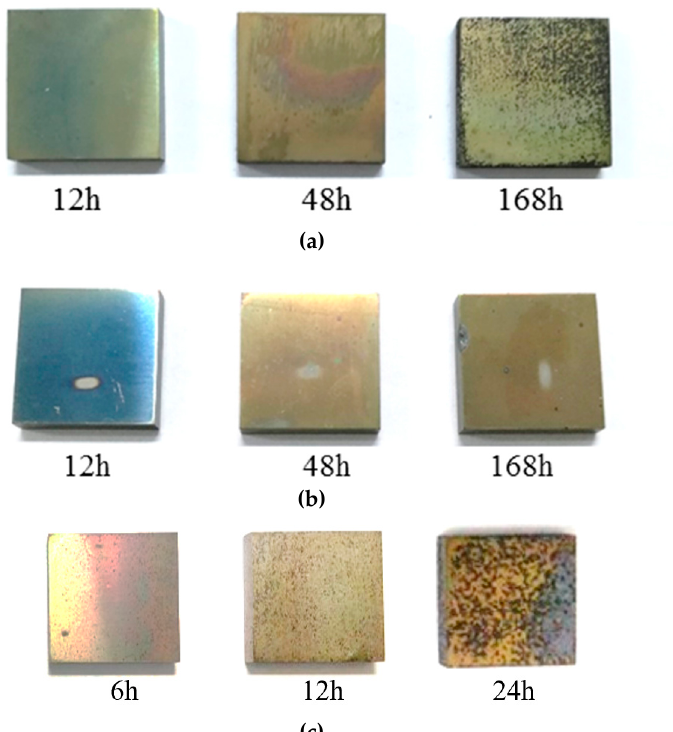
Figure 4. Macroscopic morphologies of austenitic heat-resistant steels at 700 ◦ C and 800 ◦ C. ( a ) TP347H at 700 ◦ C; ( b ) TP347HFG at 700 ◦ C; ( c ) TP347H at 800 ◦ C.